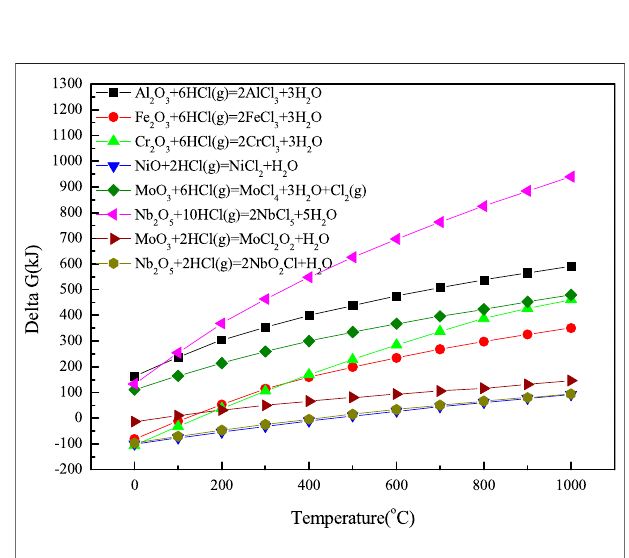
FIGURE 6 | Temperature dependence of Gibbs free energy for the reaction between metal oxides and HCl calculated by HSC6.0.